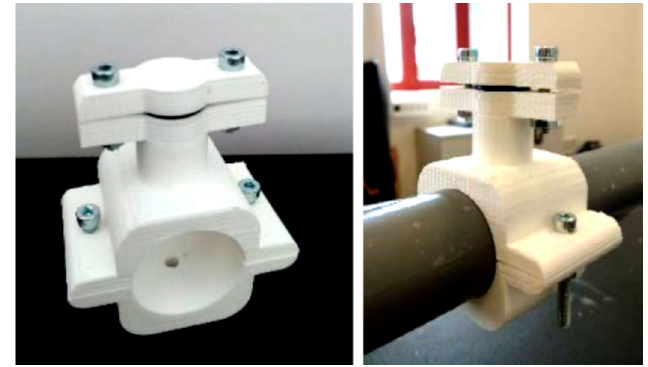
Figure 2. Clamp with stopper ( left ), mounted on the bench ( right ).